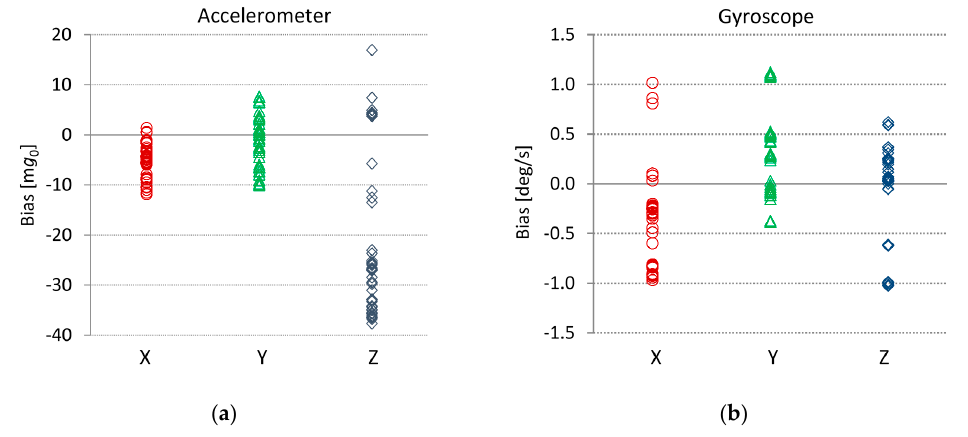
Figure 2. 3D gyroscope and 3D accelerometer biases obtained from multiple measurements on several smartphones. Values are shown in a scatter diagram with each of the axes plotted in a separate vertical column. Biases are calculated by averaging N = 600 sensor signal samples at a sampling frequency f s = 60 Hz; the corresponding averaging time is therefore τ = 10 s. ( a ) Accelerometer biases presented in m g 0 have slightly different dynamic ranges; ( b ) Gyroscope biases presented in deg/s have similar dynamic